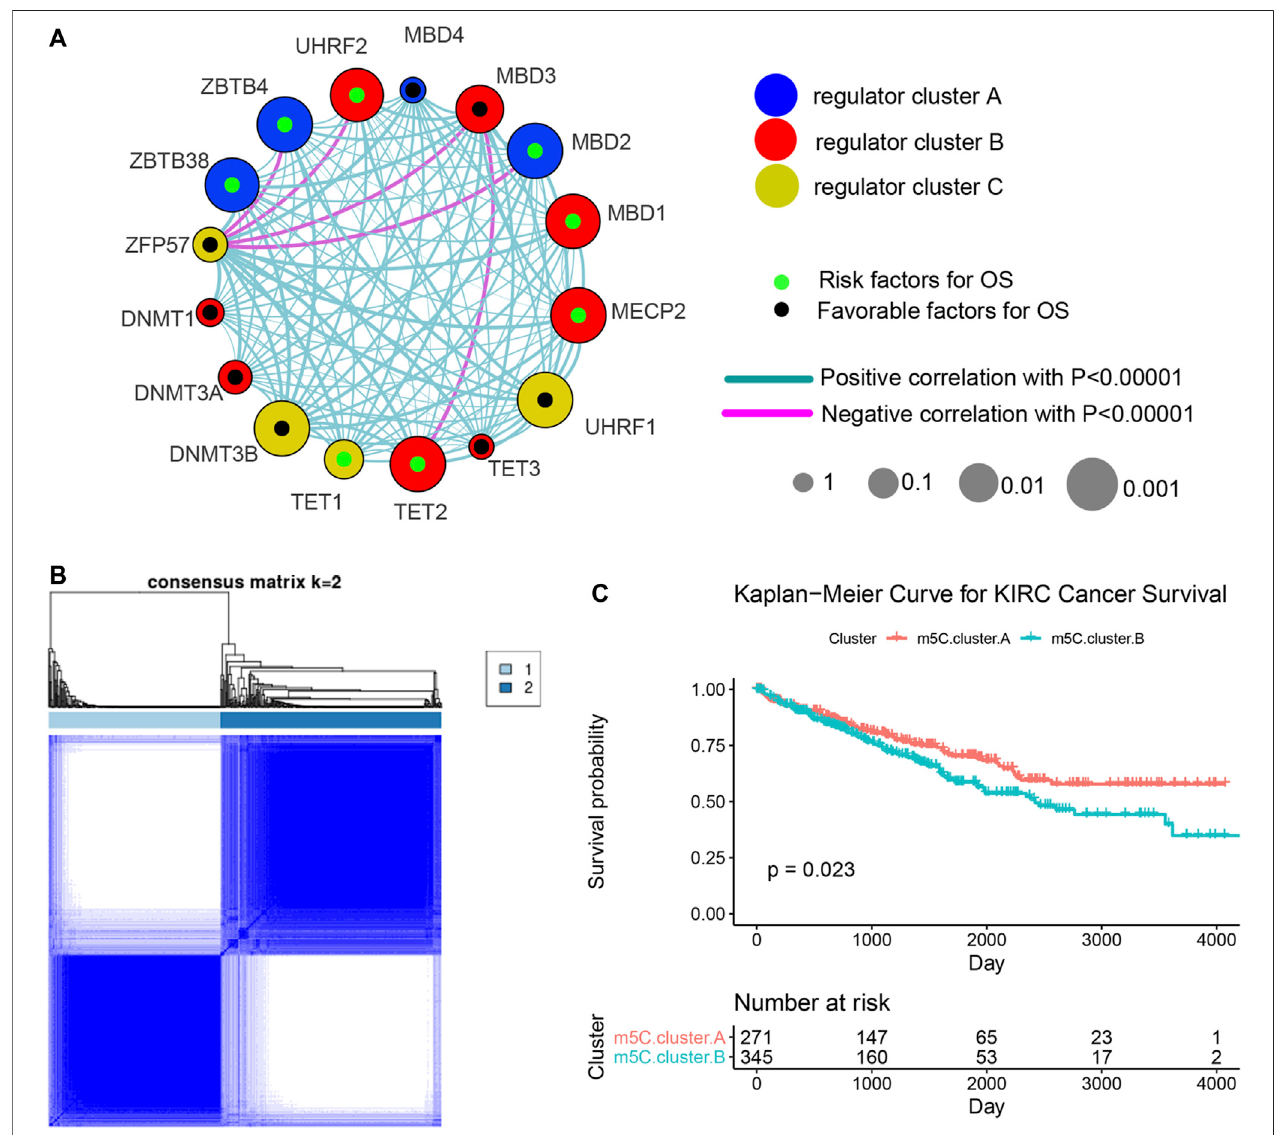
FIGURE 2 | Machine learning algorithms identify m 5 C modi fi cation patterns mediated by the regulators. (A) Comprehensive landscape of the interactions of the 17 m 5 Cregulators,interactionnetwork,andtheprognosticimplicationsforccRCCpatients. (B) Unsupervisedclusteringbasedonexpressionof17 m 5 Cregulators. (C) Overall survival curves of ccRCC patients in the two m 5 C modi fi cation pattern clusters.